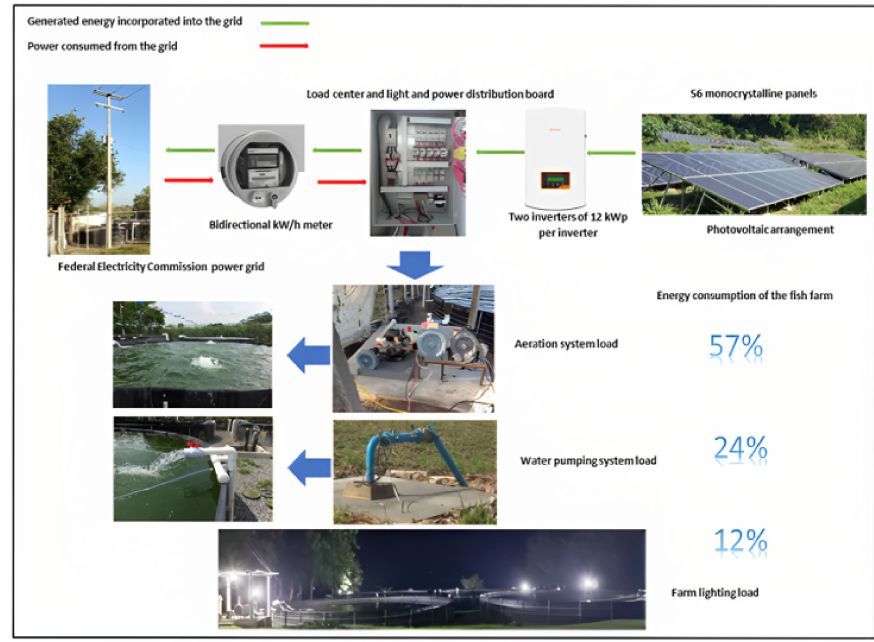
Figure 11. Schematic of an On Grid-PV connected system for an aquaculture farm.